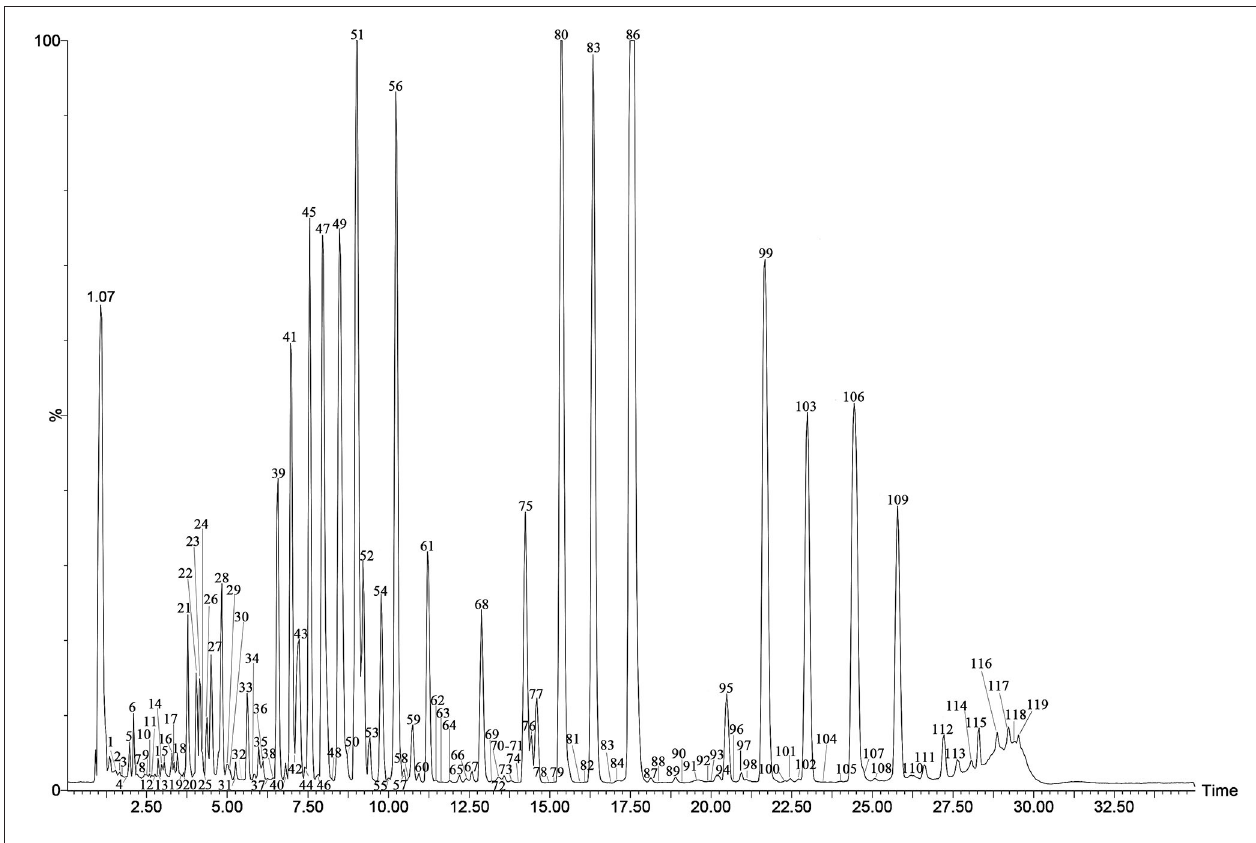
FIGURE 2 | The TIC chromatogram of the QC of Fushen in ESI −